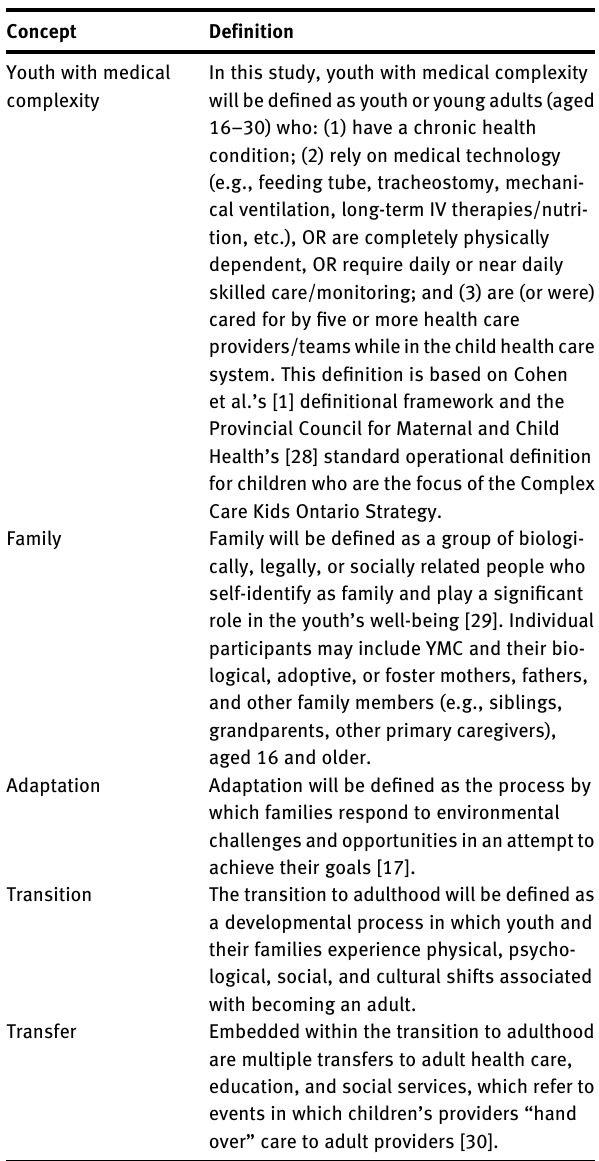
Table  : De fi nitions of key concepts binding the